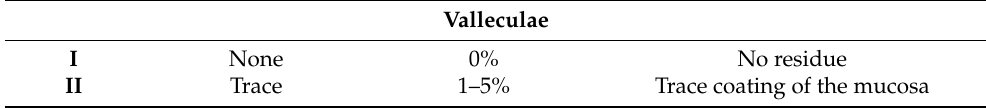
Table 1. Severity definitions for valleculae and pyriform sinus